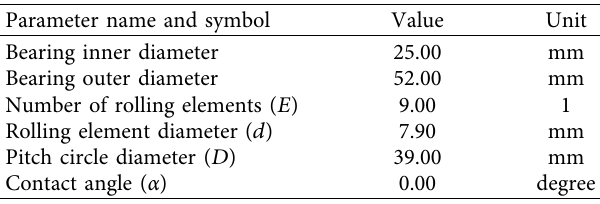
Table 1: Specifications of JEM SKF 6205-2RS deep groove ball bearing with inner ring fault.